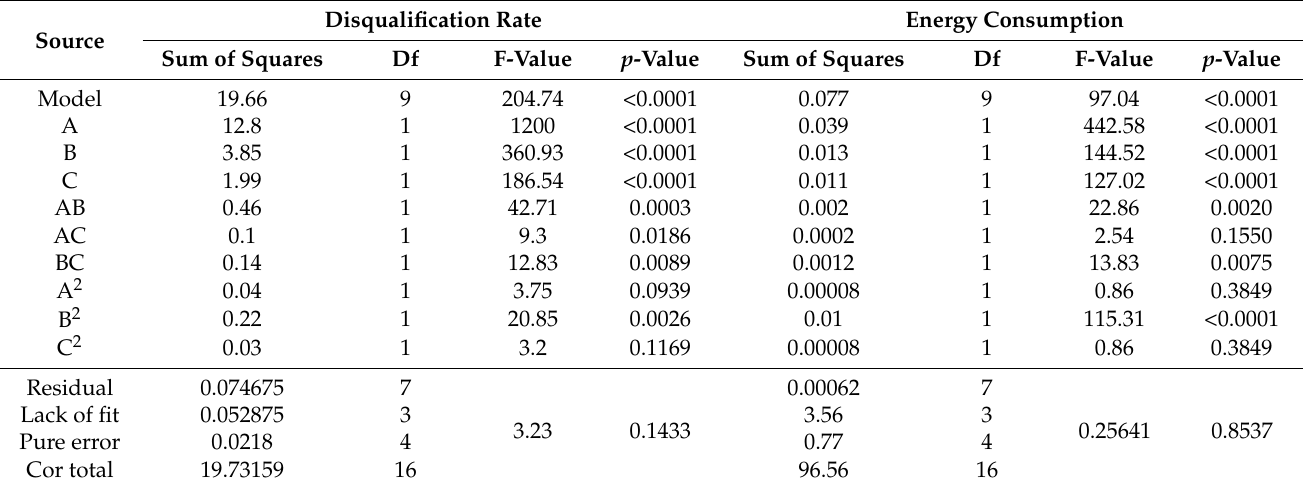
Table 4. Variance and analysis of regression